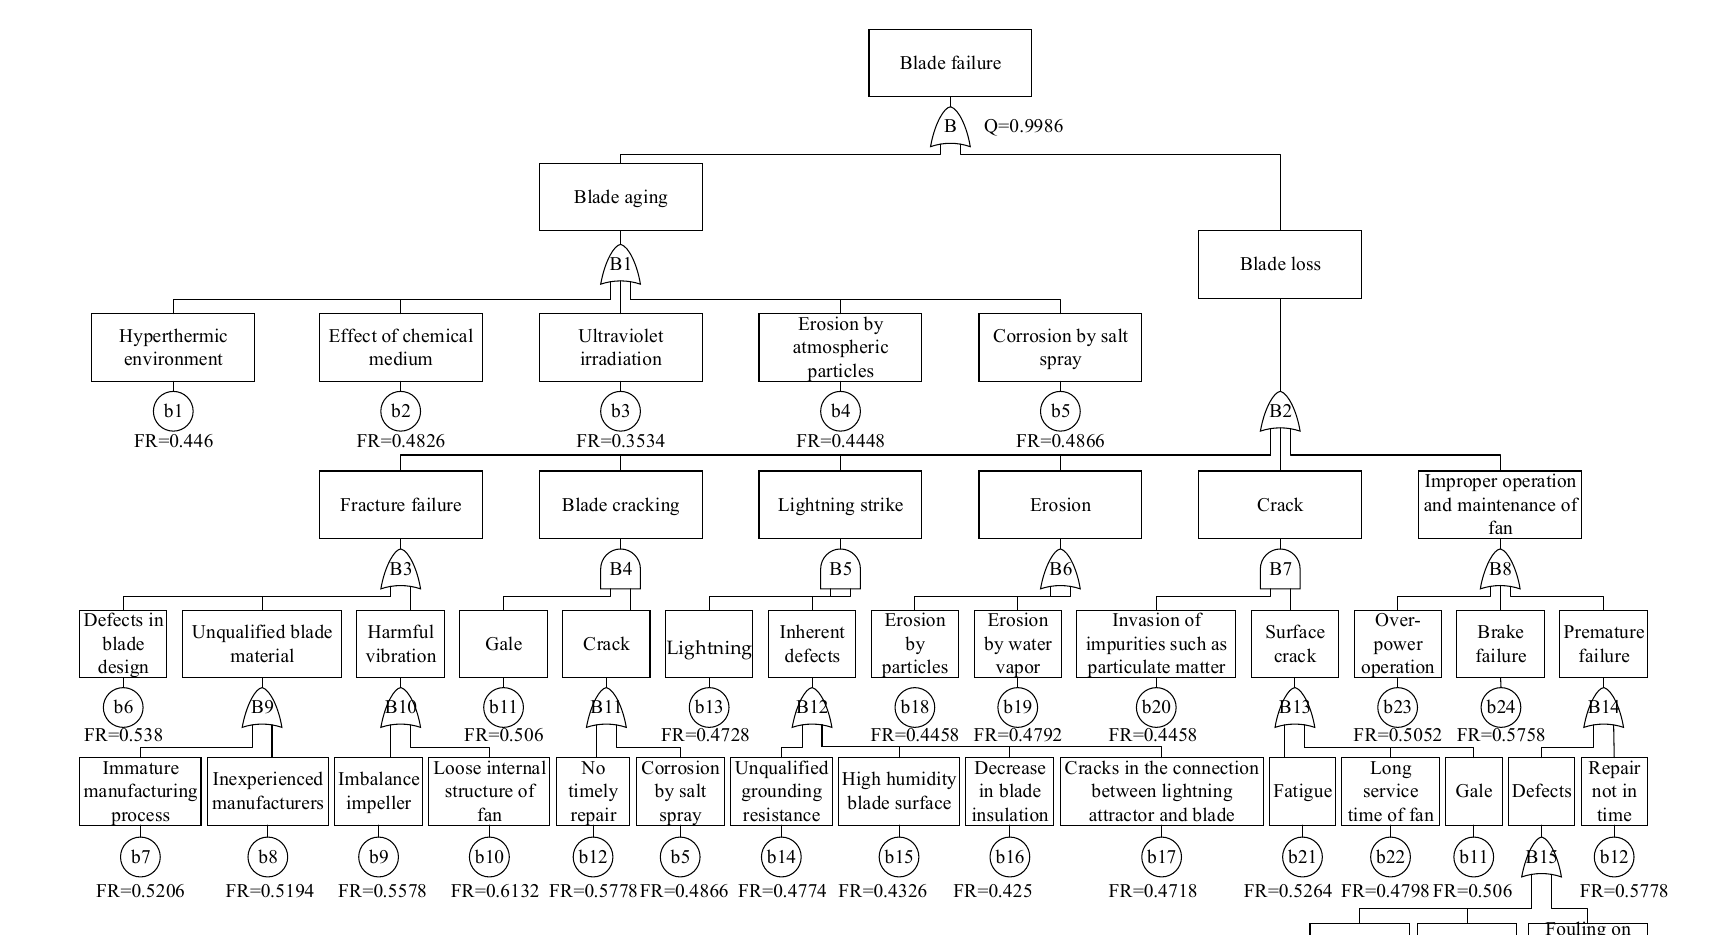
Figure 8. Fault tree analysis model for blade failure risk of the offshore wind farm.